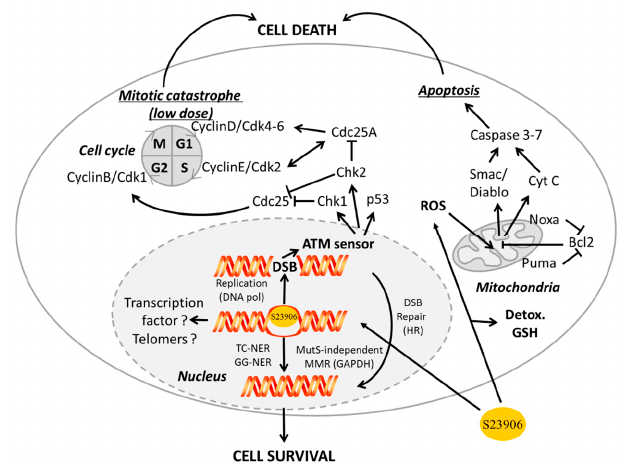
Figure 3. General scheme of S23906-1 cellular mechanism of action and repair. ROS, reactive oxygen species; CytC, cytochrome C; Detox, detoxification process; DSB, double strand break; DNApol, DNA polymerase; TC-NER, transcription-coupled nucleotide excision repair; GG-NER, global genome nucleotide excision repair; MMR, mismatch repair; HR, homologous repair. Solid and dash circles represent the cellular membrane and the nucleus, respectively. M, G1, S and G2 correspond to the different phases of the cell cycle. Open arrows and stop arrows correspond to activation and inhibition, respectively.